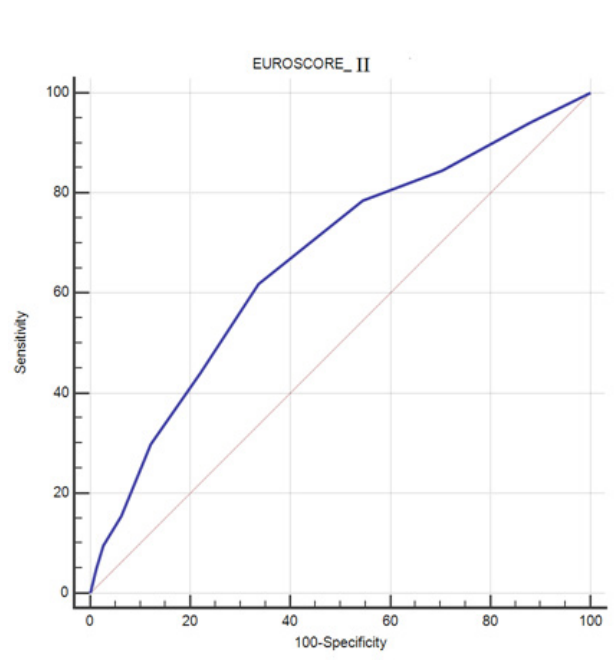
Fig. 1 - Area under the ROC curve for EuroSCORE